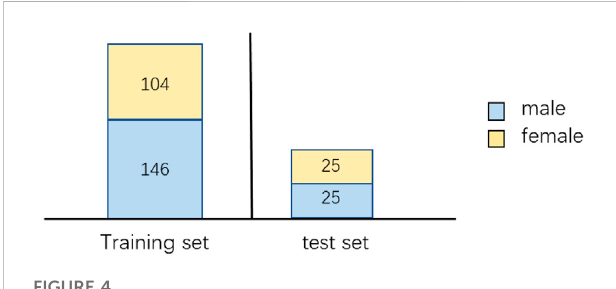
FIGURE 4 Number of samples for male and female in training and test